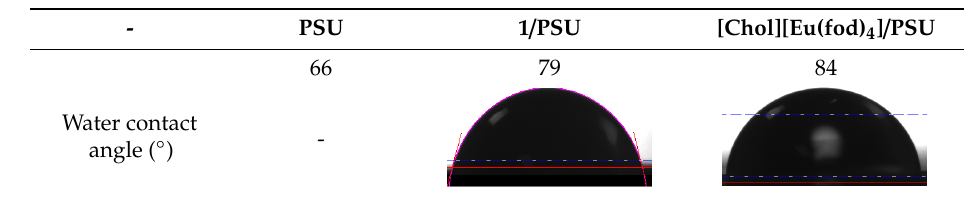
Figure 8. ( a ) SEM image of top surface PSU with 1000× magnification. ( b ) SEM image of top surface of 1/PSU (10% w / w ) nanocomposite with 1000× magnification showing micelles formed by 1 . ( c ) SEM image of top surface of [Chol][Eu(fod) 4 ]/PSU (10% w / w ) nanocomposite with 1000× magnification. Table 3. Water contact angles of pristine PSU and modified PSU membranes with 10% of 1 and [Chol][Eu(fod) 4 ].